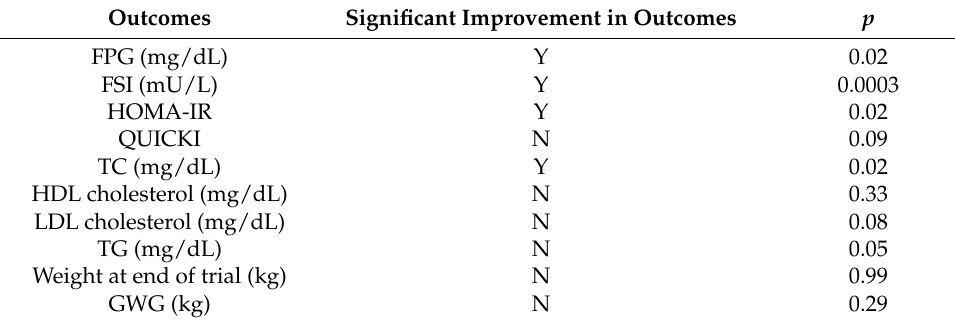
Table 2. The main findings of this meta-analysis [36].